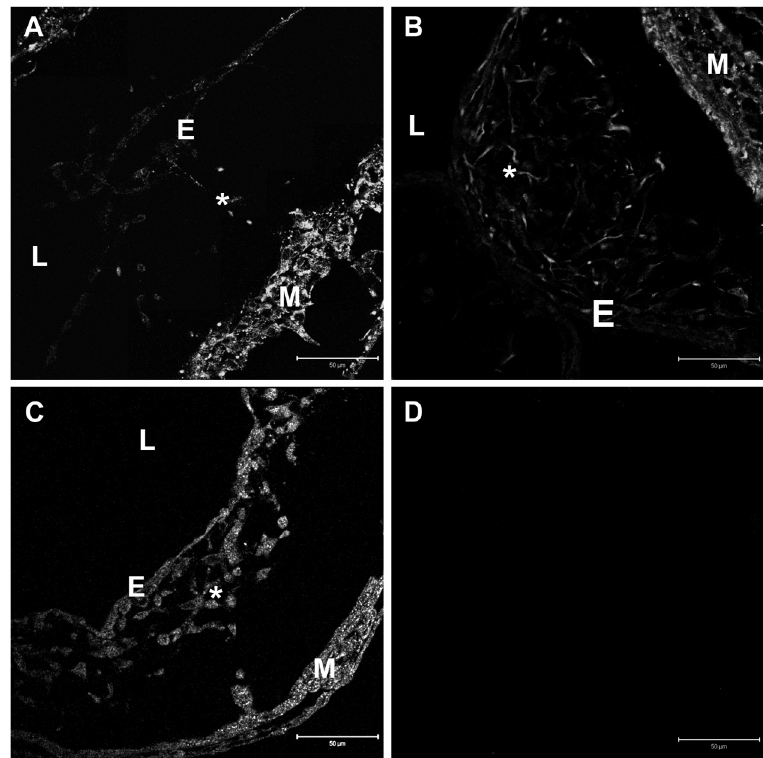
Figure 7. Immunohistochemical localization of β2 integrin in embryonic chicken hearts. A , Positive immunolabeling for β2 integrin was detected in the endothelial and myocardial layers of stage HH14 chicken heart. B , Higher magnification of the boxed area in A . C , β2 in - tegrin was present in the endothelium, mesenchymal cells, epicardium, and myocardium at HH20. D , Higher magnification of the boxed area in C . B (inset), Control section adjacent to that seen in A showing no reaction when the primary antibody was omitted. E = endo-E = endo- thelium; Ep = epicardium; L = lumen; M = myocardium; * = mesenchymal cells. Magnification bars: A , C = 100 µm; B , D = 50 µm.